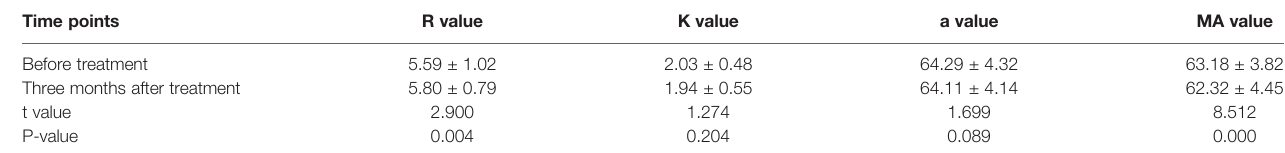
TABLE 4 | Comparison of TEG parameters three months after treatment and before treatment in the LMWH group (mean ± standard deviation). Time points R value Before